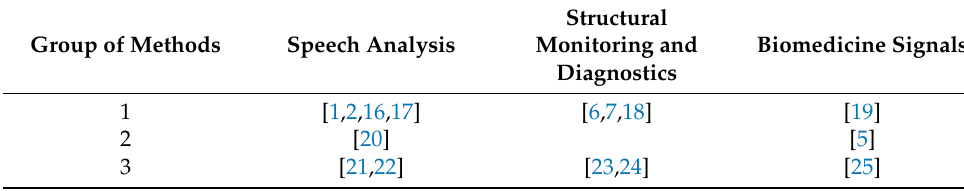
Table 1. The real-world applications that have used autoregressive models with noise.